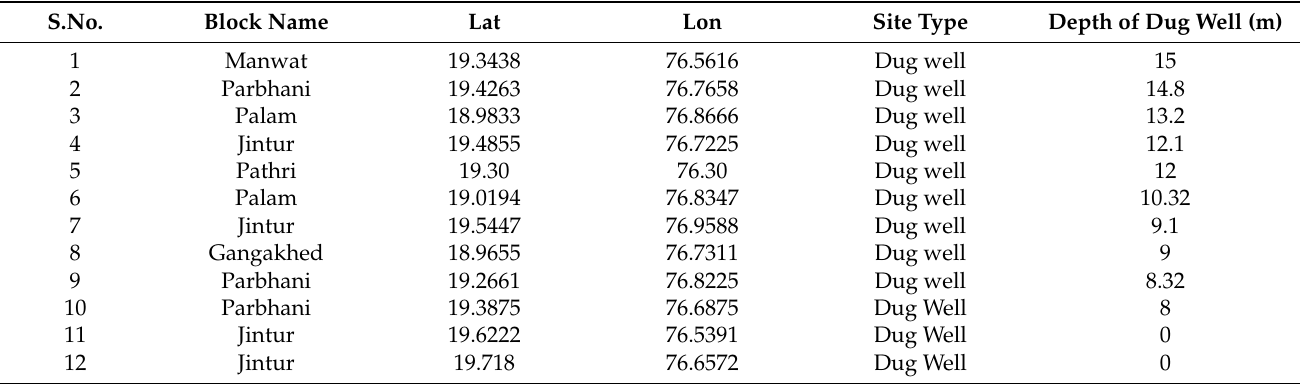
Figure 9. Scatter plot showing the relationship between dug well depth and groundwater potential. Table 6. Location and depth of dug well in the study area .